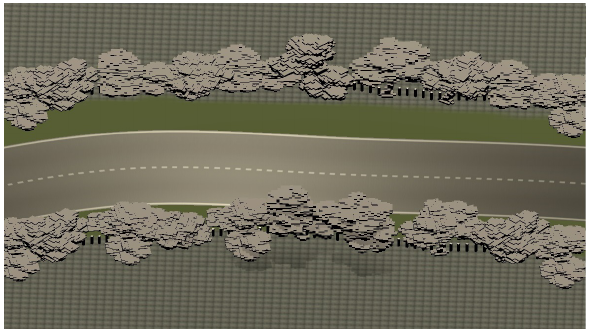
Figure 5. Voxelised trees.